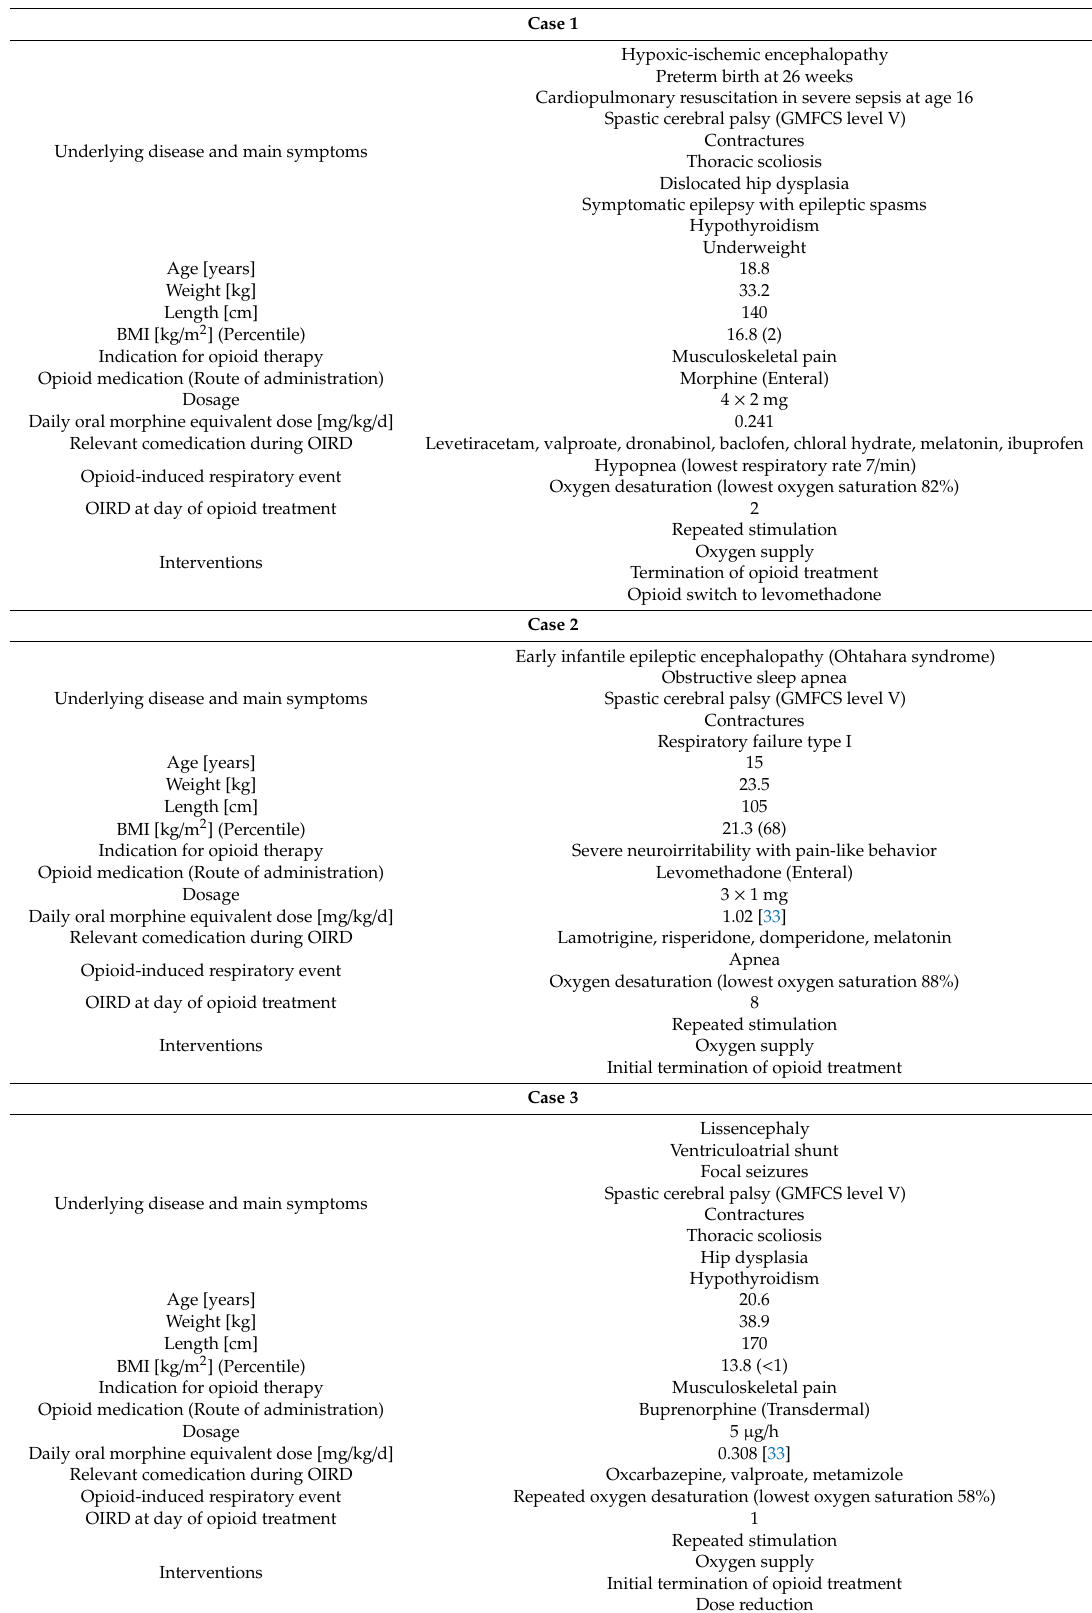
Table 3. Patient